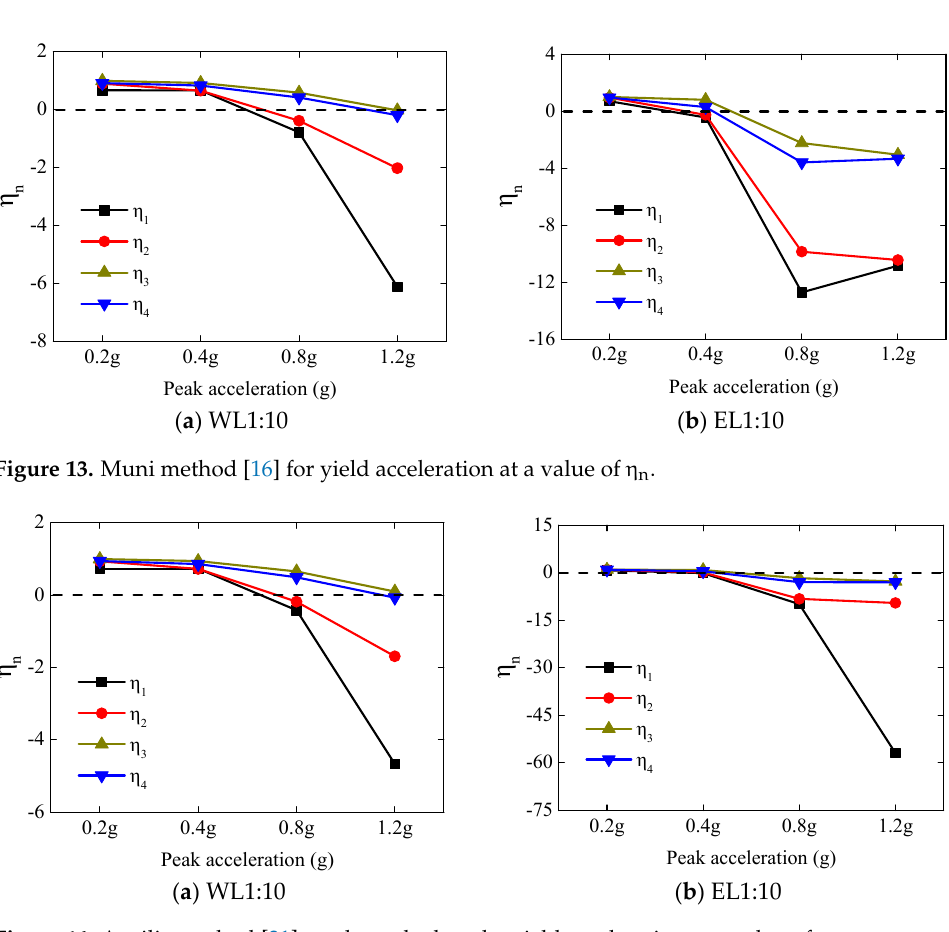
Figure 14. Ausilio method [31] used to calculate the yield acceleration at a value of η n